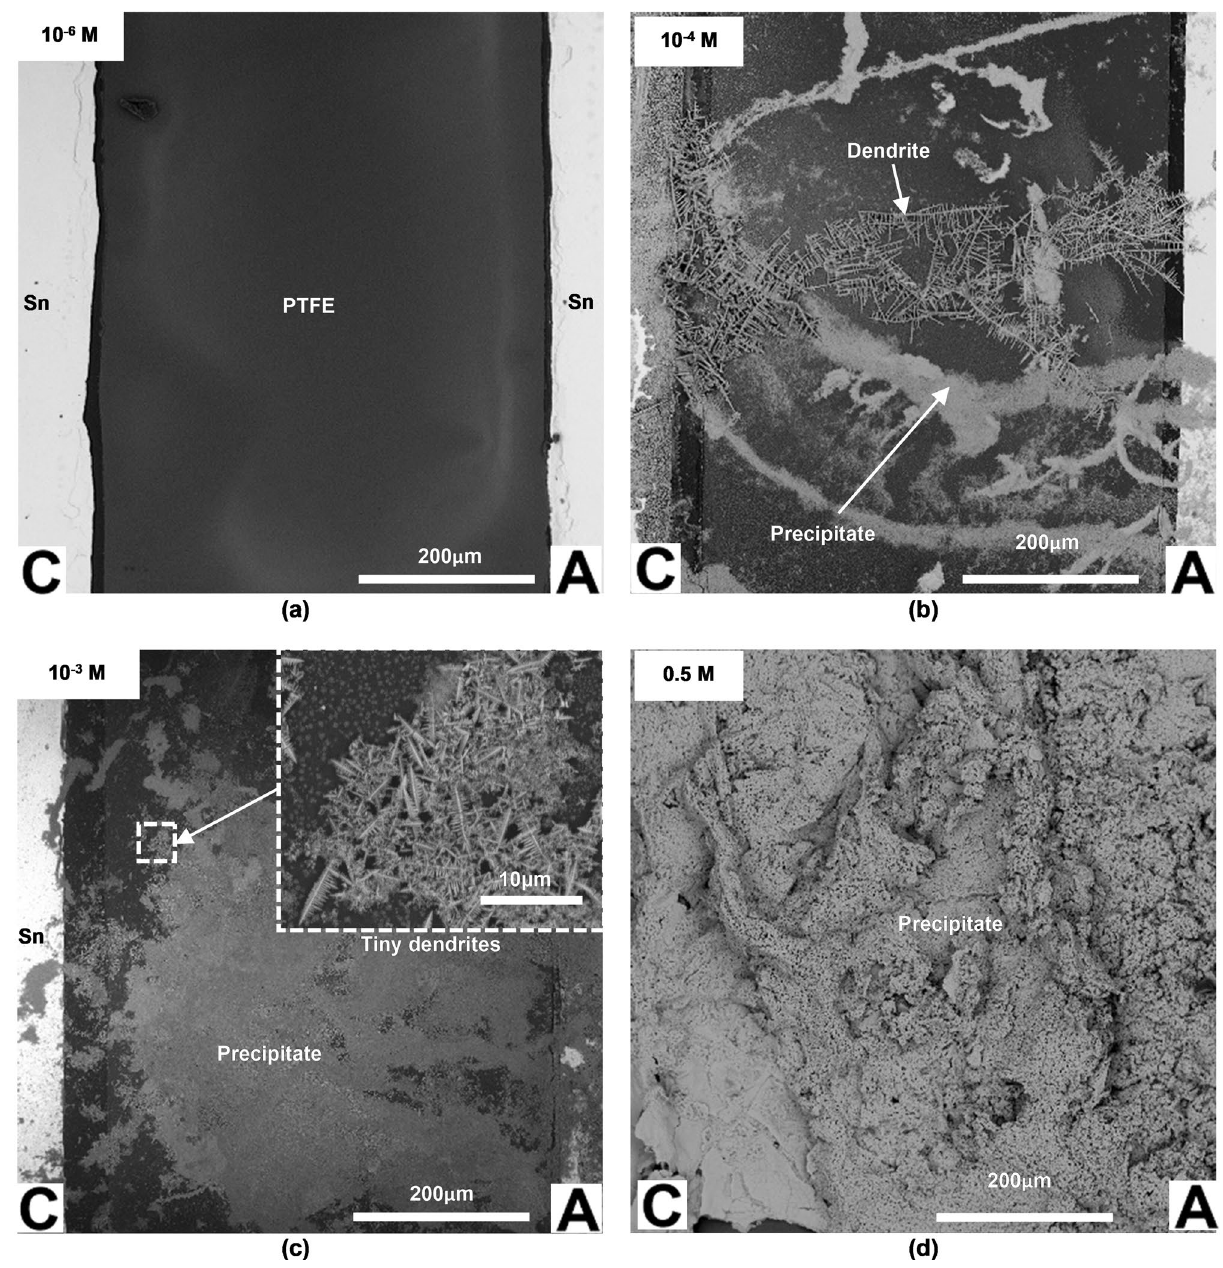
Figure 5. SEM images of the products formed at the area between two oppositely charged Sn electrodes after 450 s of WDT, at an applied bias voltage of 3 V, in electrolytes with various Br − concentrations: ( a ) 10 −6 M; ( b ) 10 −4 M; ( c ) 10 −3 M; ( d ) 0.5 M ( C cathode; A